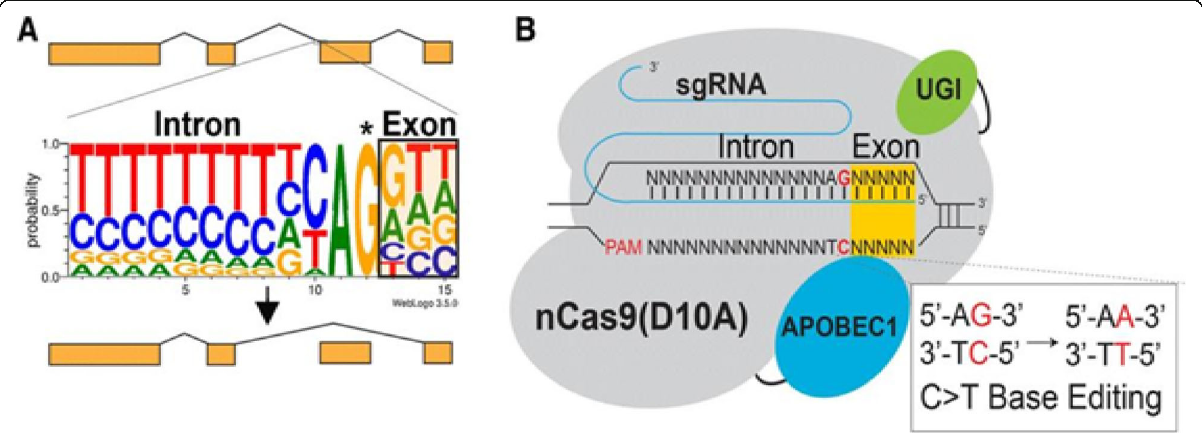
Fig. 6 Essential steps in CRISPR-SKIP targeting approach: a Nearly every intron ends with a guanosine (asterisked G). It is hypothesized that mutations that disrupt this highly conserved G within the splice acceptor of any given exon in genomic DNA would lead to exon skipping by preventing incorporation of the exon into mature transcripts base. b In the presence of an appropriate PAM sequence, this G can be effectively mutated by converting the complementary cytidine to thymidine using CRISPR-Cas9 C>T single-base editors. (From